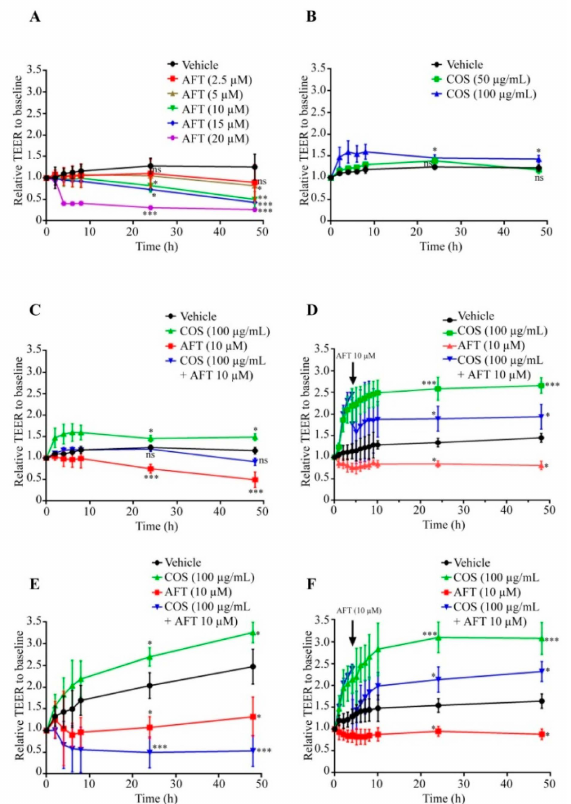
Figure 1. Effect of afatinib and COS on the tight junction assembly. TEER across T84 cell monolayers was measured at different time intervals after incubation with the indicated concentrations of afatinib ( A ) and COS ( B ). ( C ) The effect of afatinib and COS either alone or in combination on tight junction assembly. ( D ) Preventive effect of COS on afatinib-induced tight junction disruption. ( E ) Tight junction assembly measurements using Ca 2+ switch assays. T84 cell monolayers were exposed to Ca 2+ free media. After 16 h, Ca 2+ free media were replaced with normal media containing afatinib and COS followed by TEER measurement across T84 cell monolayers. ( F ) Preventive effect of COS on afatinib-induced tight junction disruption measured by Ca 2+ switch assays. Data are expressed as the means of TEER ± SD ( n = 5) (one-way ANOVA; * p < 0.05; ** p < 0.01; *** p < 0.001 compared with vehicle treated